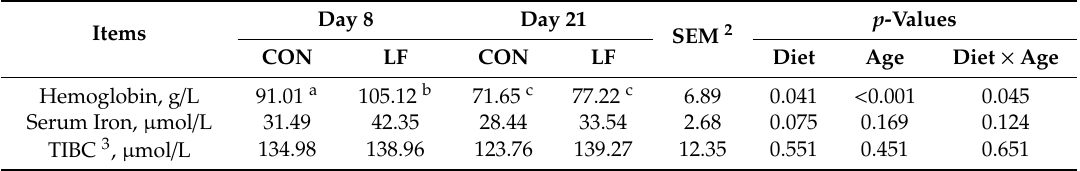
Table 2. E ff ects of lactoferrin on serum iron parameters of suckling piglets 1 .